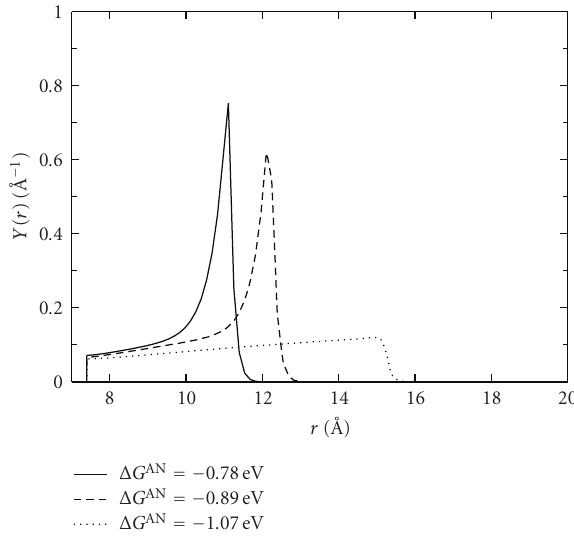
Figure 8: Free energy curves of a D-A pair with Δ G AN = − 1 . 1 eV in a nonpolar solvent. Curves for pairs with di ff erent molecular radii and in di ff erent solvents are compared.